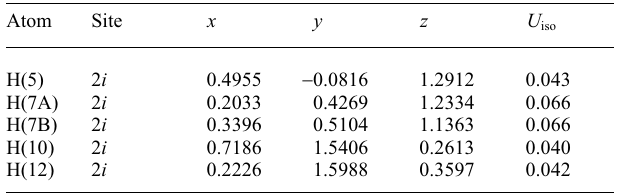
Table 2. Atomic coordinates and displacement parameters (in Å 2 )